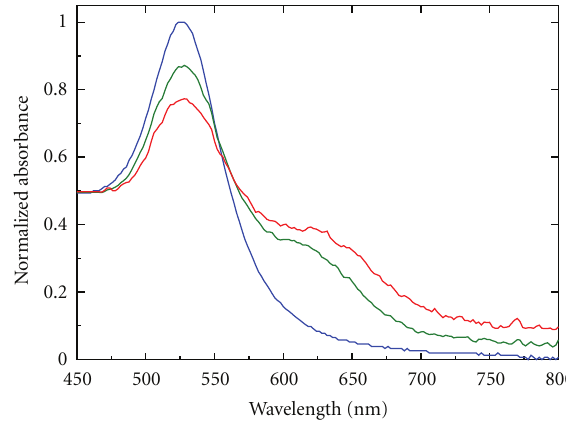
Figure 4: Normalized extinction spectra of mPEG stabilized single particles (blue solid line) and electrophoretically purified dimer (green solid line) and trimer (red solid line)